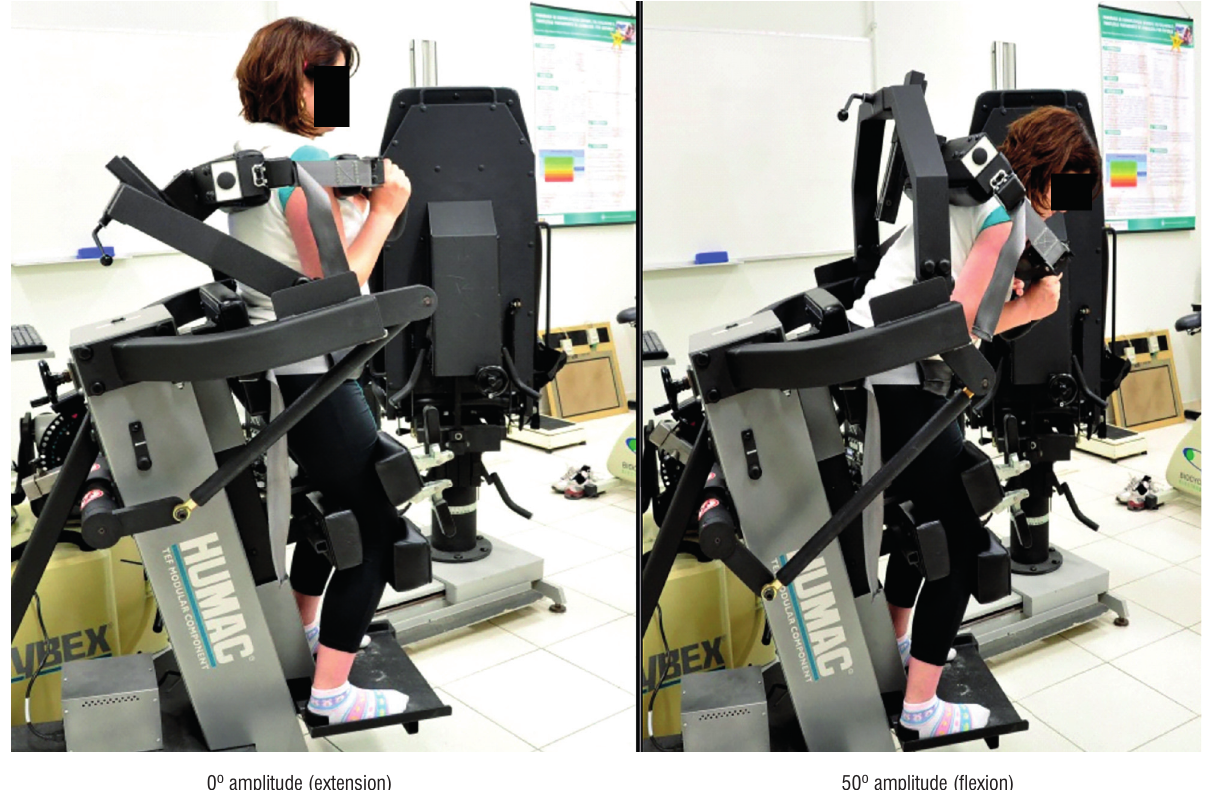
Figure 1 - Isokinetic test amplitude (side view) Source: Research